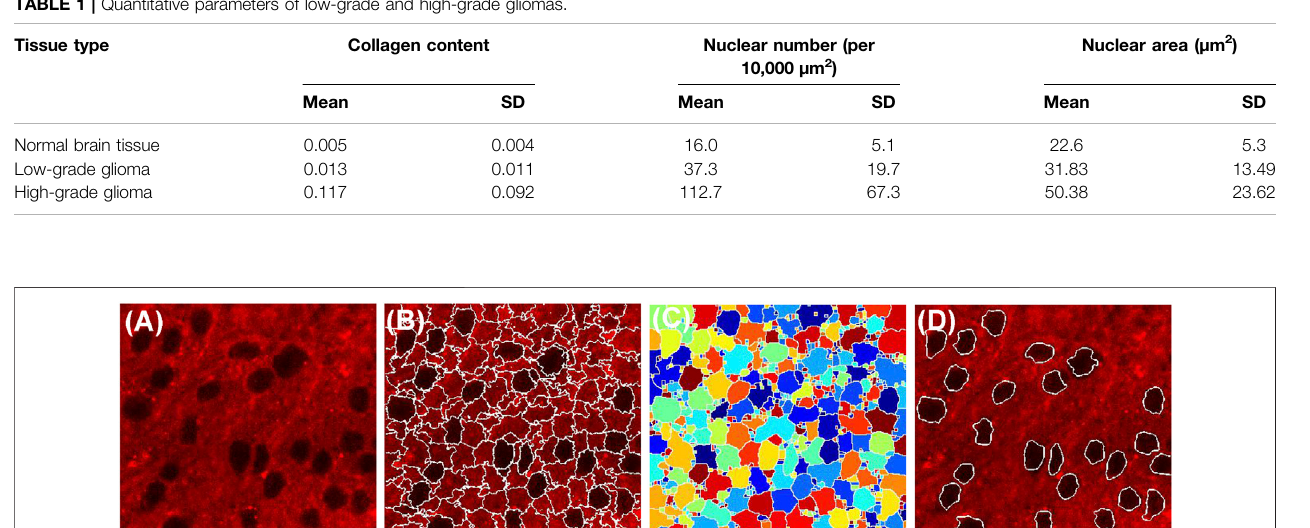
TABLE 1 | Quantitative parameters of low-grade and high-grade gliomas.